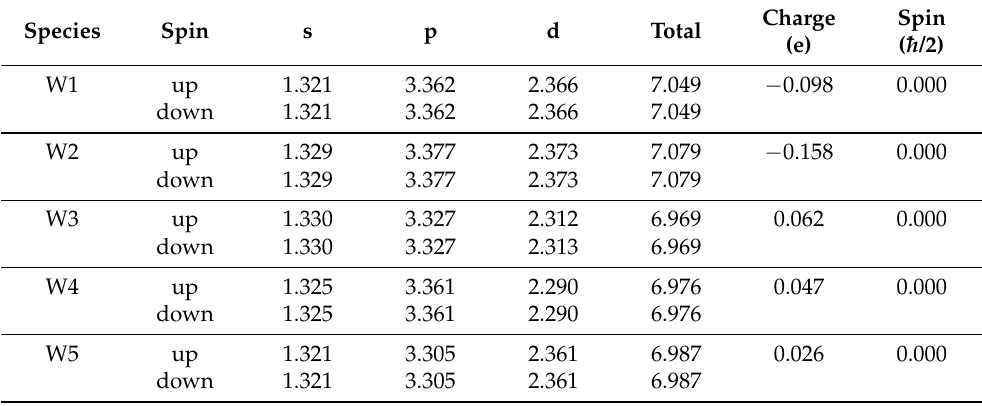
Table A6. Atomic populations (Mulliken) for mq-GOpt As 2 S 3